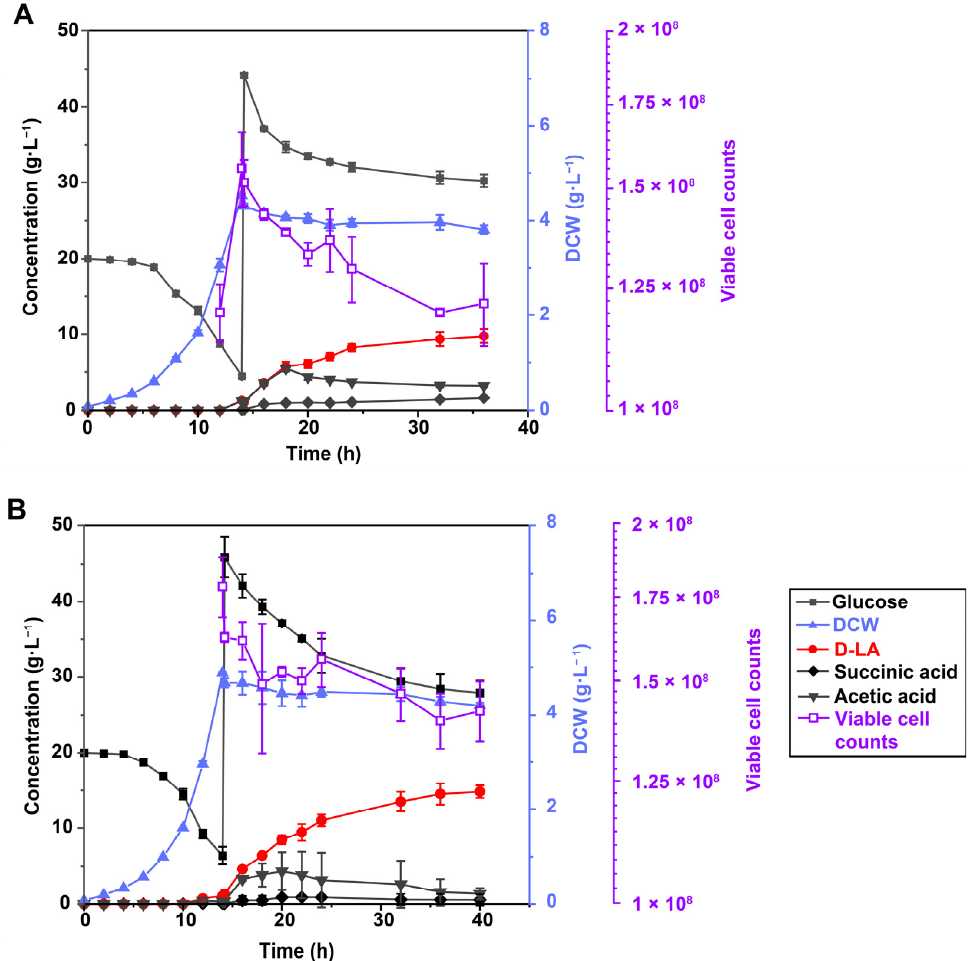
Figure 5. DCW, viable cell counts, glucose, and product concentrations during fermentation process under pH 5.5 in 5 L bioreactor. ( A ) E. coli LBBE31P. ( B ) E. coli LBBE317PGA.